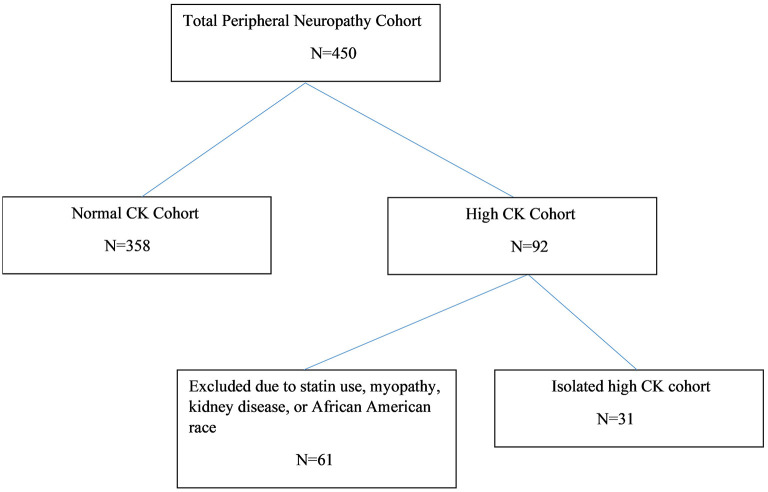
Peripheral neuropathy patient disposition diagram.